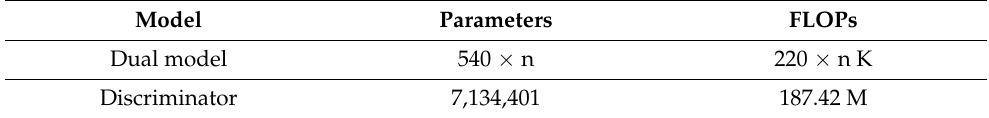
Table 7. The parameters and FLOPs of the dual model and discriminator for dual learning/GAN- based methods.